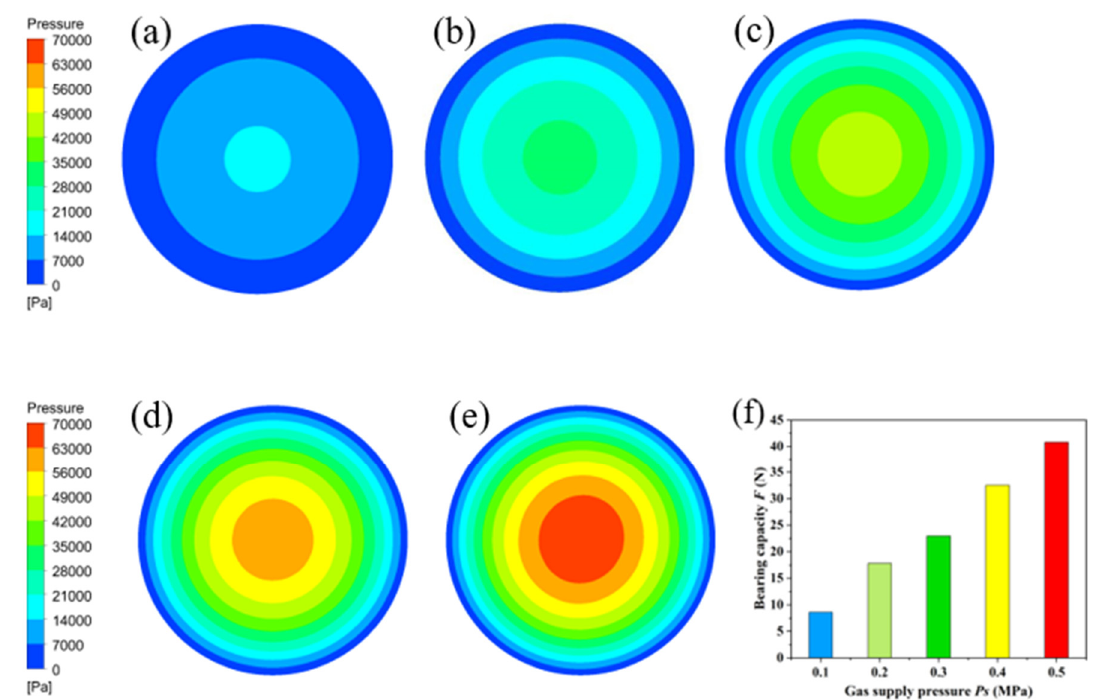
Figure 7. Distribution of gas pressure on the bearing’s surface with different air supply pressure: ( a ) 0.1 MPa, ( b ) 0.2 MPa, ( c ) 0.3 MPa, ( d ) 0.4 MPa, ( e ) 0.5 MPa and ( f ) the relationship between bearing capacity and gas supply pressure. Table 2. The static measurement of experimental parameters of the air bearing.